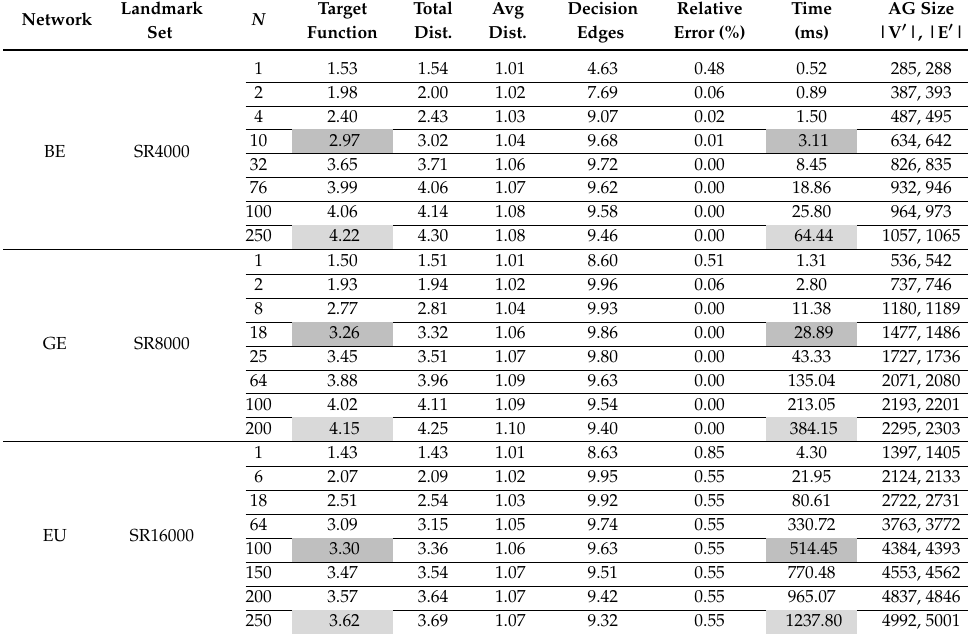
Table 1. Quality measures and execution times of TDAG. The background colors in certain cells highlight specific values of the target function and the corresponding execution times of TDAG’s query algorithm, per instance and landmark set. These values are used in Table 2, for comparison with the baseline approaches for time-dependent alternative